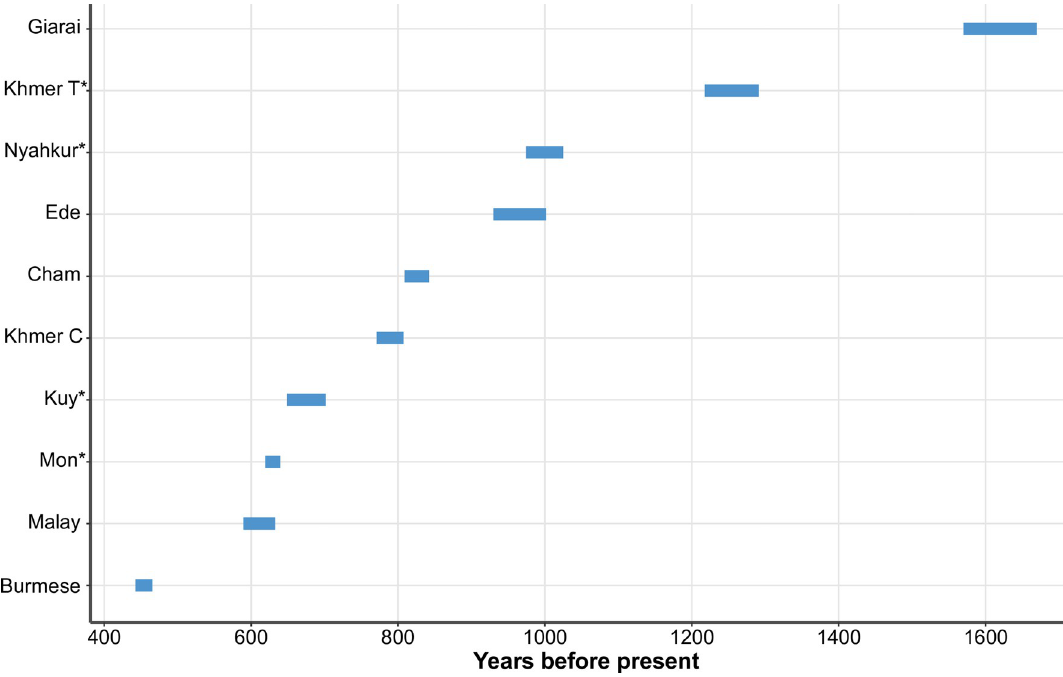
Fig 8. Dates of South Asian admixture events inferred by fastGLOBETROTTER. The plot shows 95% confidence intervals of admixture dates estimated from 100 bootstrap replicates. Asterisks after population names indicate that these populations are newly genotyped in this